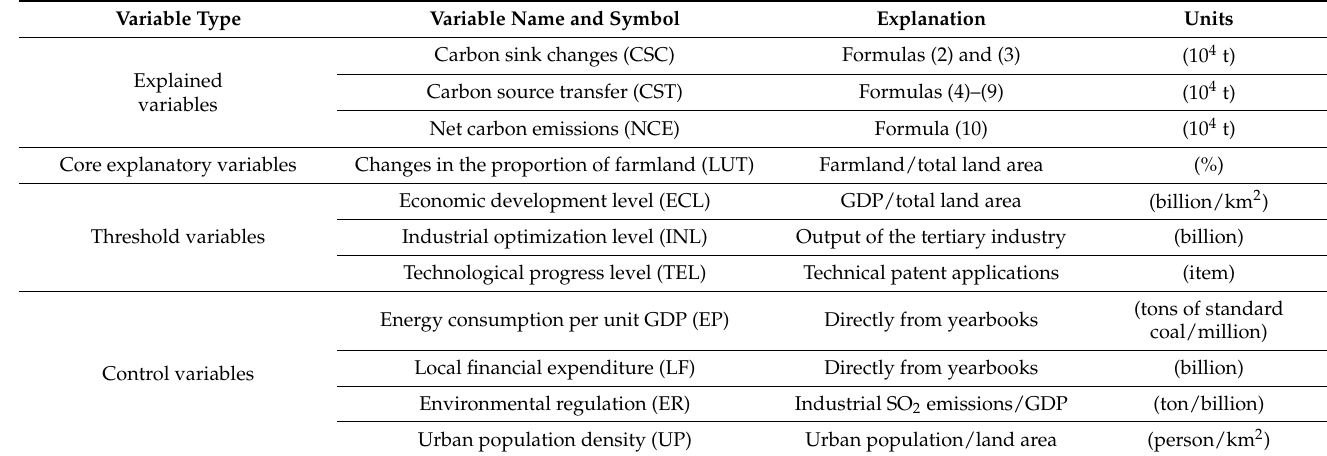
Table 2. Variable selection and